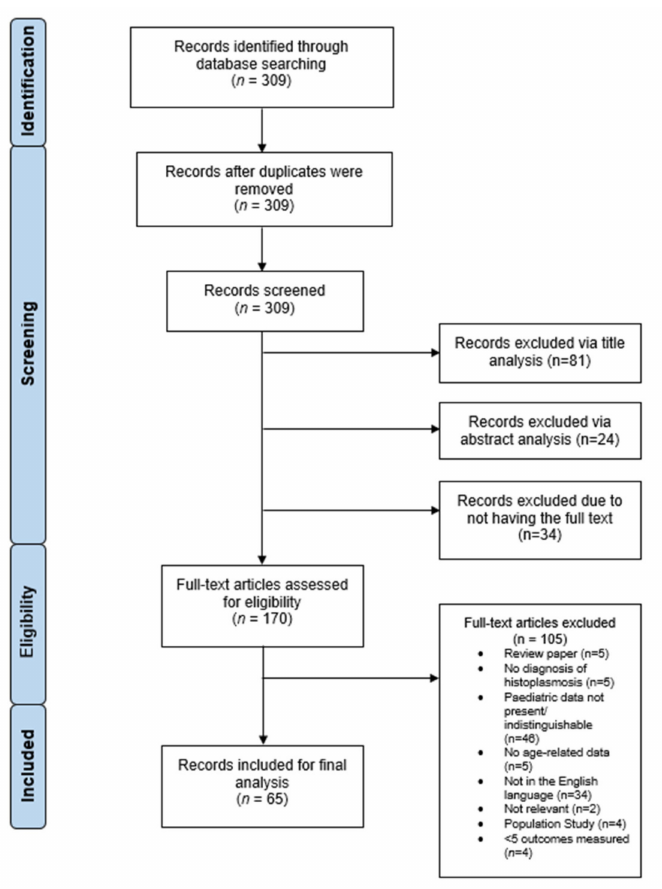
Figure 1. PRISMA flow chart demonstrating the process of inclusion/exclusion of histoplasmosis studies for analysis. The initial literature search found 309 papers related to histoplasmosis. Of these, 81 were excluded via title analysis, 24 were excluded via abstract analysis and 34 had no access to the full text. This left 170 studies, of which, 105 were excluded via full-text analysis; a total of 65 studies were included in the final analysis. Diagram adapted from Moher, D., Liberati, A., Tetzlaff, J., Altman, D.G., The PRISMA Group.